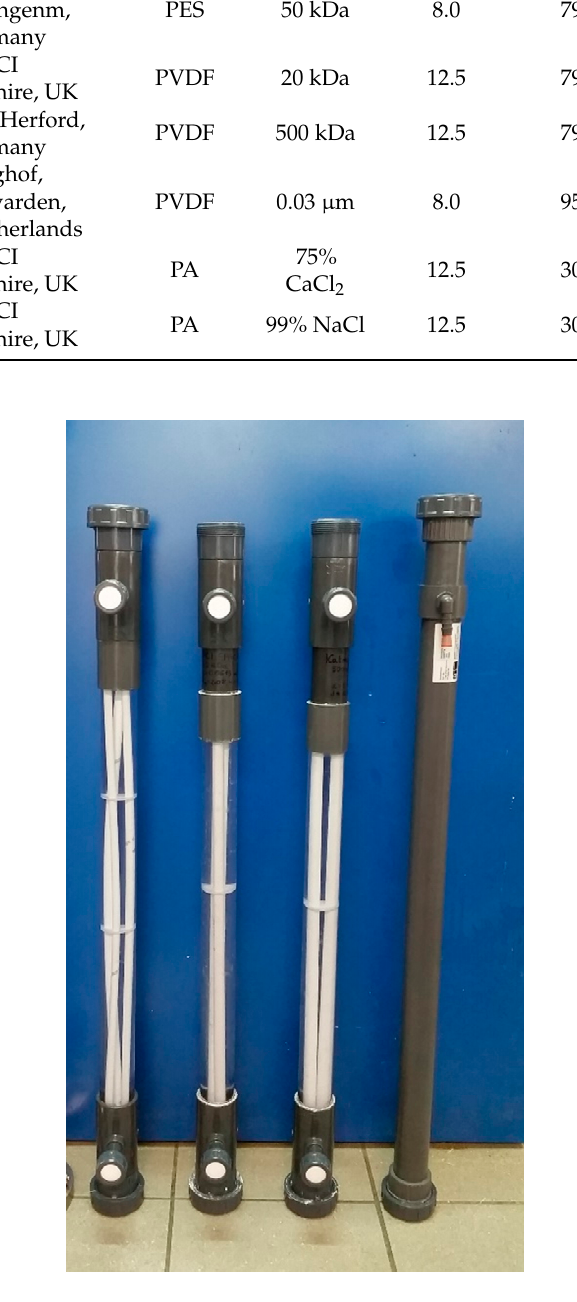
Figure 1. The modules used for low-pressure filtration. The membranes differ in their selectivity, the material they are made of, and the range of process parameters at which they can be used. An important issue is the pH and temperature range because they determine the possible ways of carrying out the chemical regeneration of the membrane. The limit values of the working parameters of the membranes used in this study are summarized in Table 4. Methods for regeneration of the membranes used were described in an earlier publication by the authors